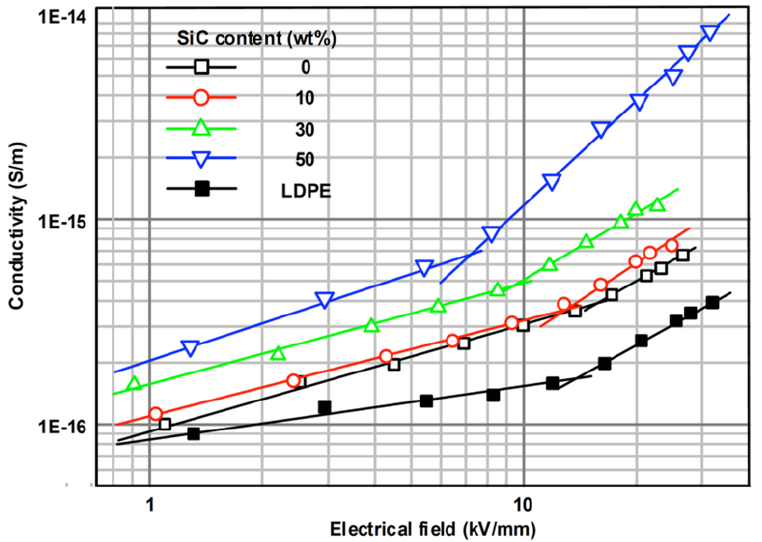
Figure 27. Conductivity ( 𝜎 ) vs. electric field ( E ) for GnP/LDPE with different concentrations. Reprinted from [74].